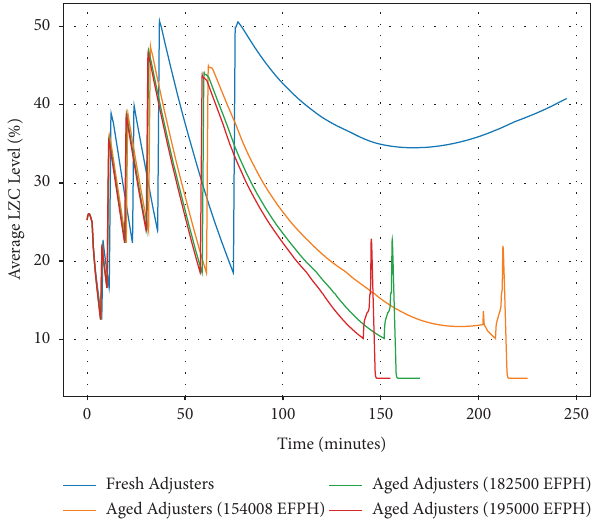
Figure 8: Efect of adjuster depletion–59% FP transient.